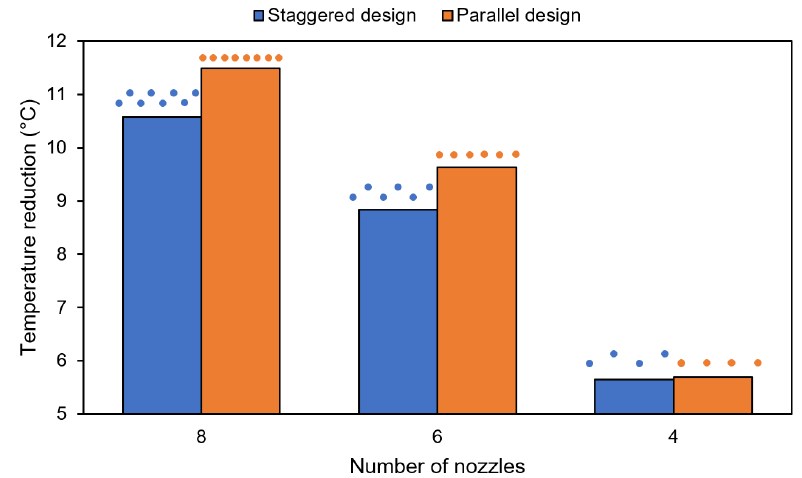
Figure 16. Comparison of the impact of the number and arrangement of nozzles on the cooling performance (ambient T = 40 °C, RH = 24.5%, U HWC = 4.4 m/s).